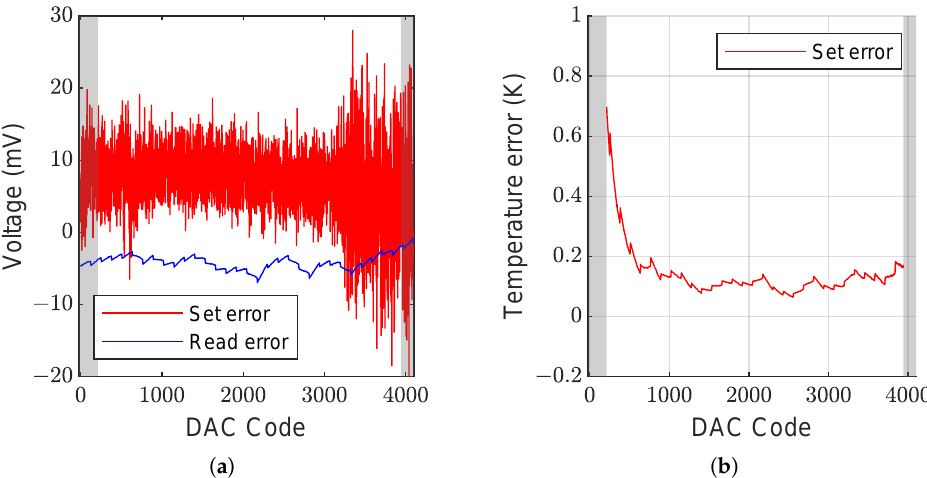
Figure 10. Characterization of set error and read error of the first channel of temperature emulator board with no output current. Set error and read error as a function of the set value ( a ); voltage set error converted in a temperature error ( b